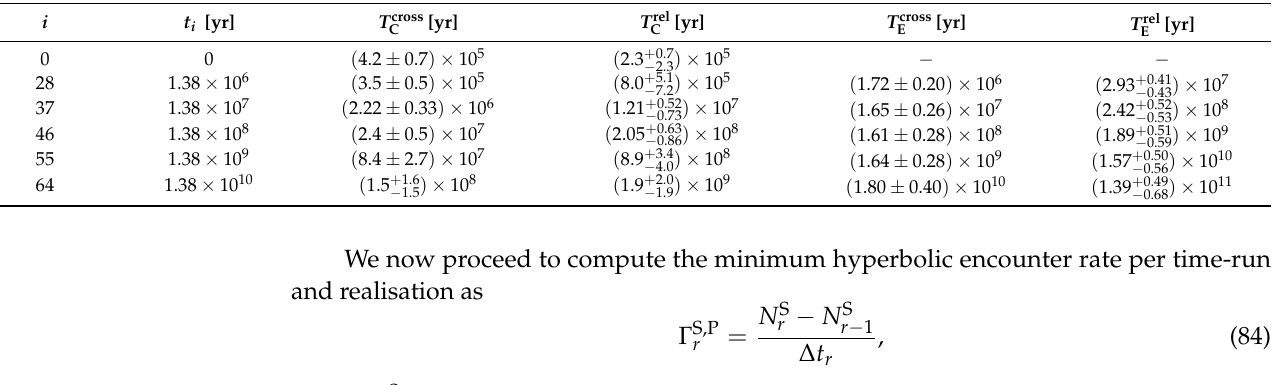
, and relaxation time, T rel , of the cluster and ejecta bubbles that populate the P P Cluster Time Scales: Ejecta Time